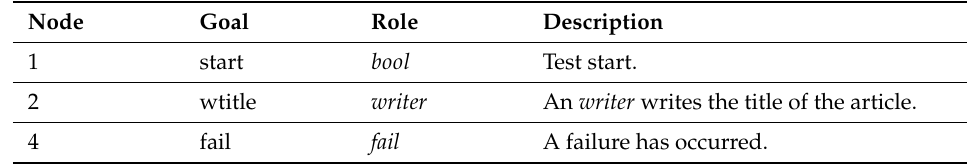
Table 7. A test case for Writing Paper obligation .